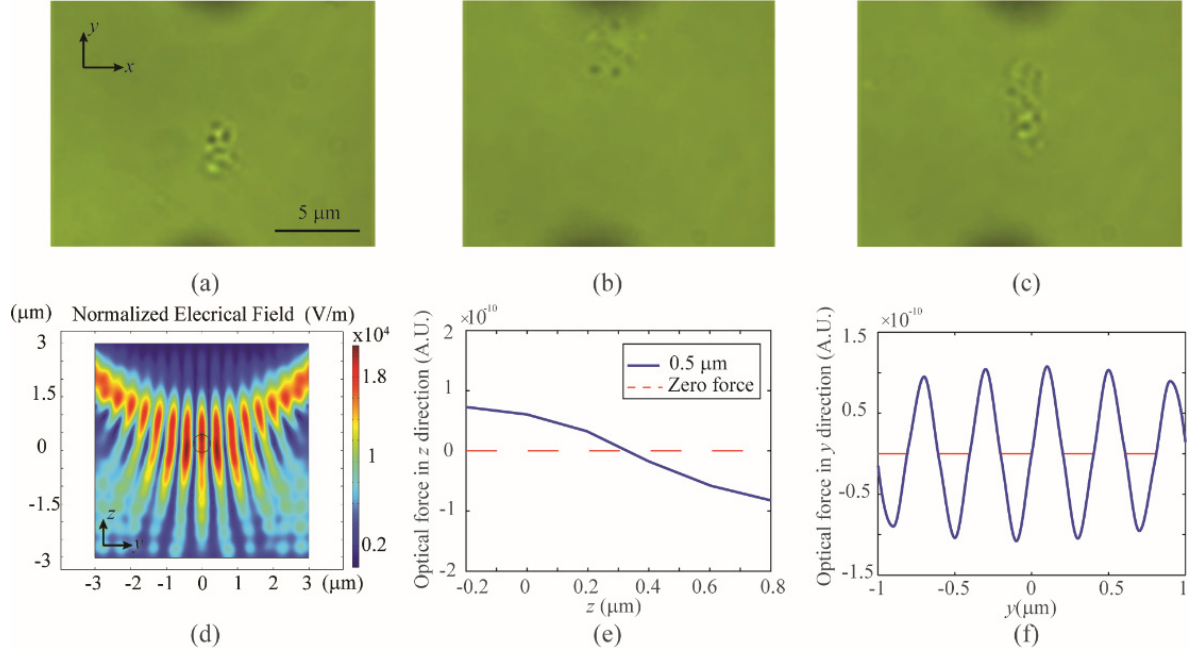
Figure 5. 3D trapping of a swarm of 500 nm silica bead particles by the dual etched fiber system. A swarm of beads trapped ( a ) and manipulated 30 µ m above the substrate. ( b ) When the dual − fiber system was moved too fast in the z − direction, the particle swarm escaped from the trap (seconds 8~11 in the Video S1). The swarm was re − trapped when the fiber system was moved back to the original height (second 12 in the Video S1). The number of beads is increased in the trap due to their violent Brownian motion. ( c ) The observed maximum number of particles in the trap (second 15 in the Video S1). The oil immersion 100x objective lens is used in this experiment. ( d ) Numerical simulation of the normalized electrical fields when two etched fibers are separated by 6 µ m ( e ) and ( f ) the simulated optical forces applied onto a 500 nm silica sphere when it was moved along the z - ( y = 0) and the y - ( z = z equilibrium ) directions.